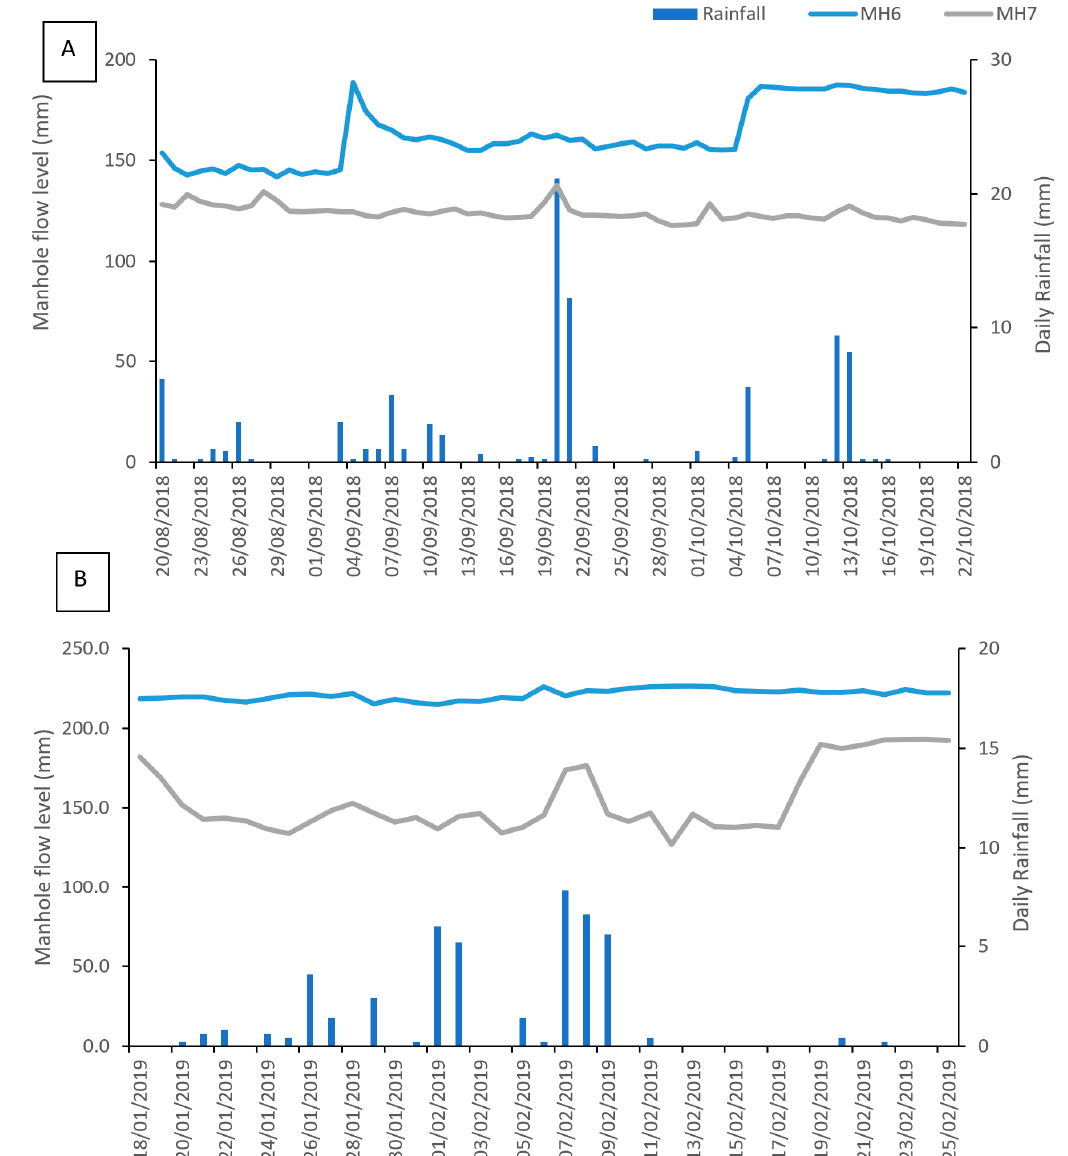
Figure 8. Level measurement in millimetres in manhole 6 (blue line) and manhole 7 (grey line) between 20 August–22 October 2018 ( A ) and 18 January–25 February 2019 ( B ). Daily rainfall is provided on a secondary axis in both. There were significant gaps in data collection between 23 October 2018–17 January 2019.